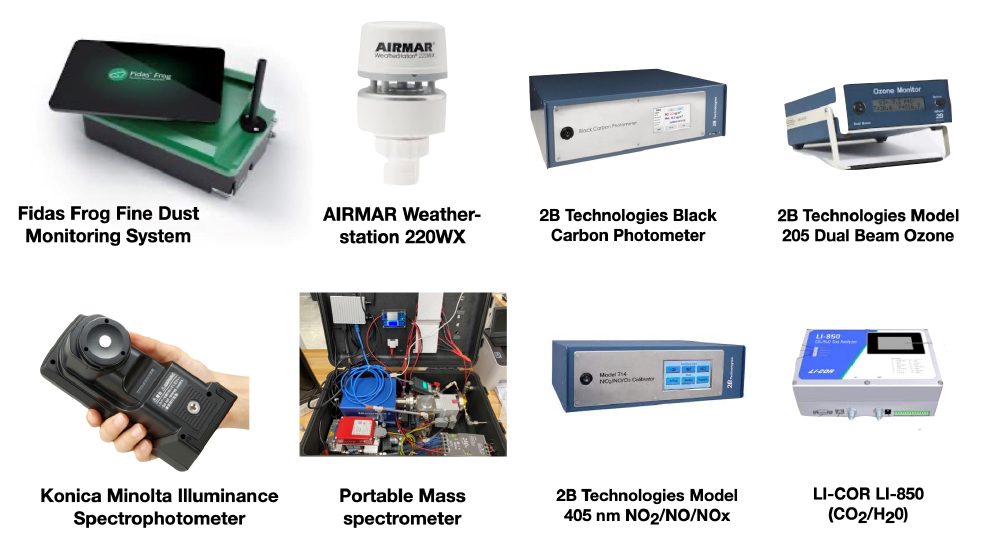
Figure 2. Images of full environmental sensing suite. Fidas ® Frog Fine Dust Monitoring Sys- tem measures particulate matter concentrations at 100 different size bins. The AIRMAR 220WX WeatherStation ® Instrument samples barometric pressure, wind speed and direction, ambient temper- ature, and more. The 2B Technologies Black Carbon Photometer measures atmospheric black carbon particulates using long-path photometry. The 2B Technologies Model 205 Dual Beam Ozone sensor is a UV-based ozone monitor. The Konica Minolta CL-500A Illuminance Spectrometer measures the spectral irradiance from 360 to 780 nm at every nanometer. The portable mass spectrometer was constructed by the UNT Laboratory of Imaging Mass Spectrometry and measures charge mass ratios ranging 1–300 amu. The 2B Technologies Model 405 nm NO 2 /NO/NO x Monitor™ directly measures atmospheric Nitrogen Dioxide (NO 2 ) and Nitric Oxide (NO). The LI-COR LI-850 Gas Analyzer measured CO 2 and water vapor in the air.